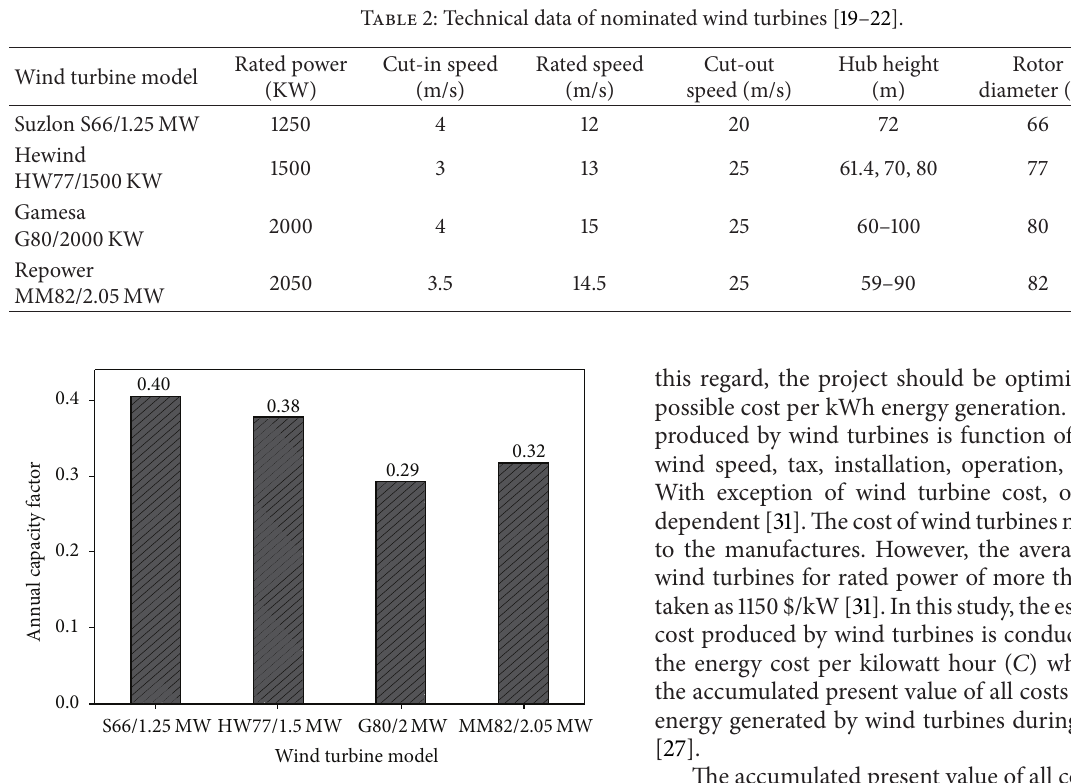
Figure 7: Annual capacity factor for nominated wind turbines at Jarandagh site.